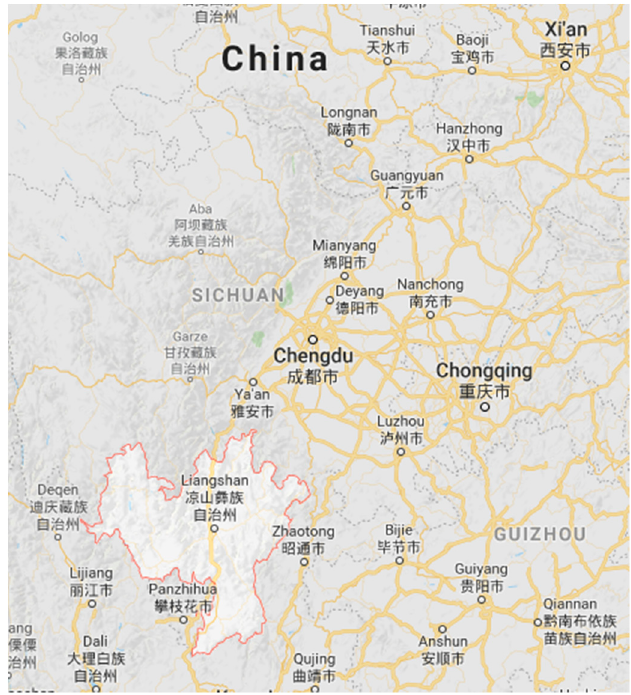
Figure 1. Geographical location of Sichuan Province and Liangshan Yi Autonomous Prefecture.